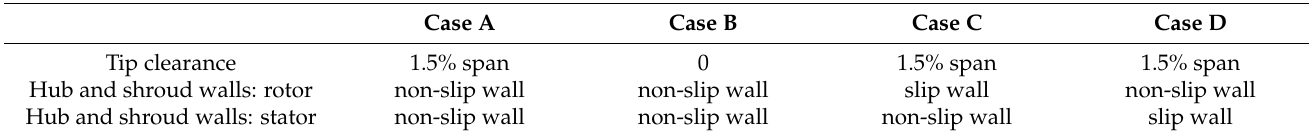
Table 3. Calculation scheme for the loss